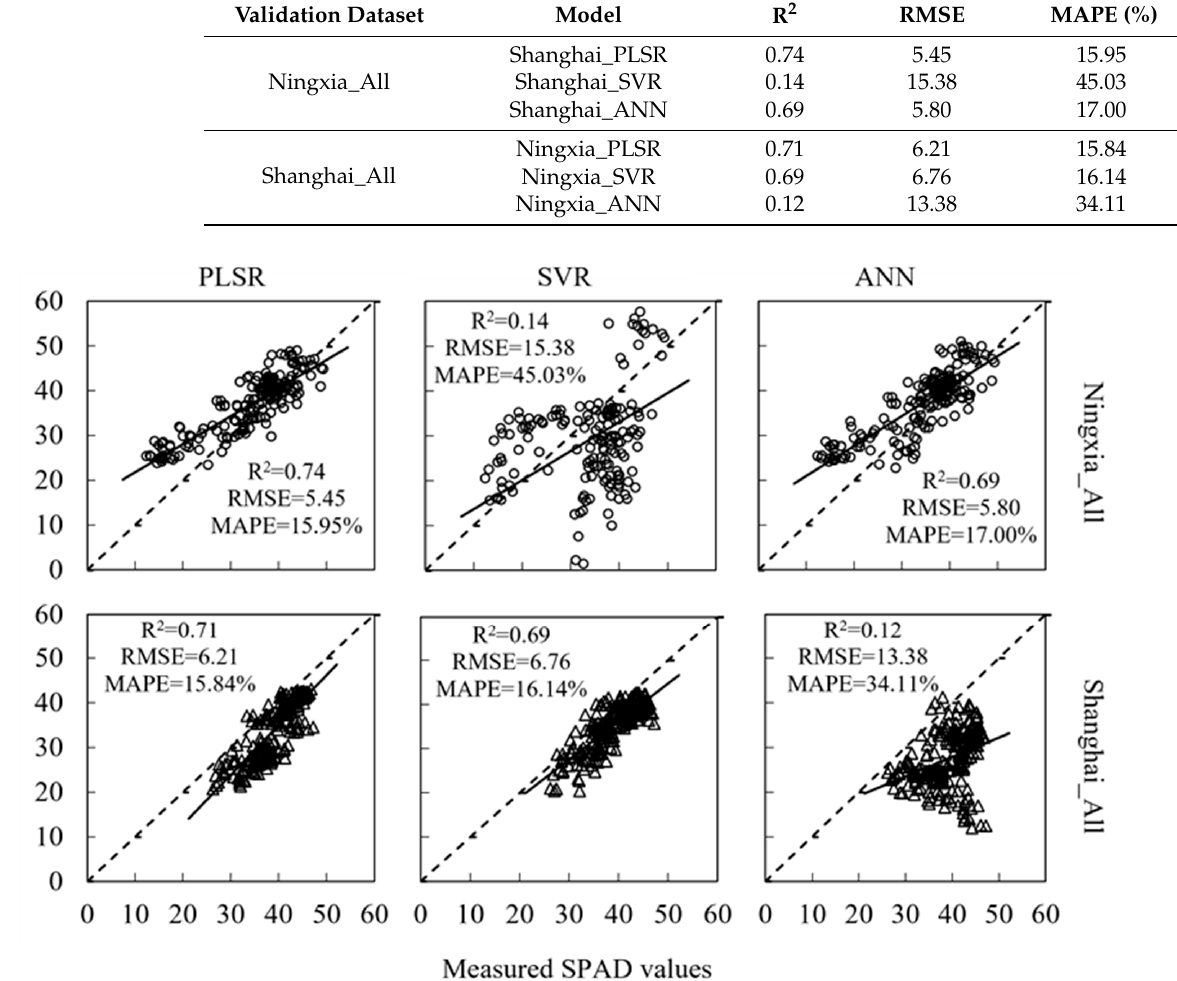
Figure 4. Measured vs. predicted LCC (SPAD values) values with different methods for different groups. ○ denotes Ningxia sample. ∆ denotes Shanghai sample.